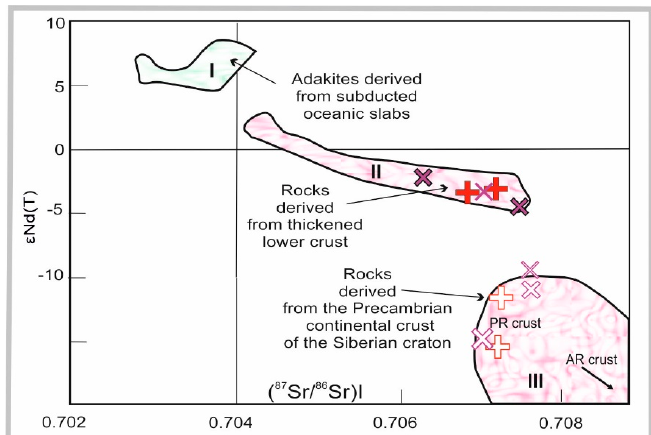
Figure 5. The location of the granitoids of the EF MOOB framing on the diagram of the ratio ( 87 Sr/ 86 Sr)i– ε Nd (t)). Fields of adakite derivatives from the subduction oceanic slab according to the